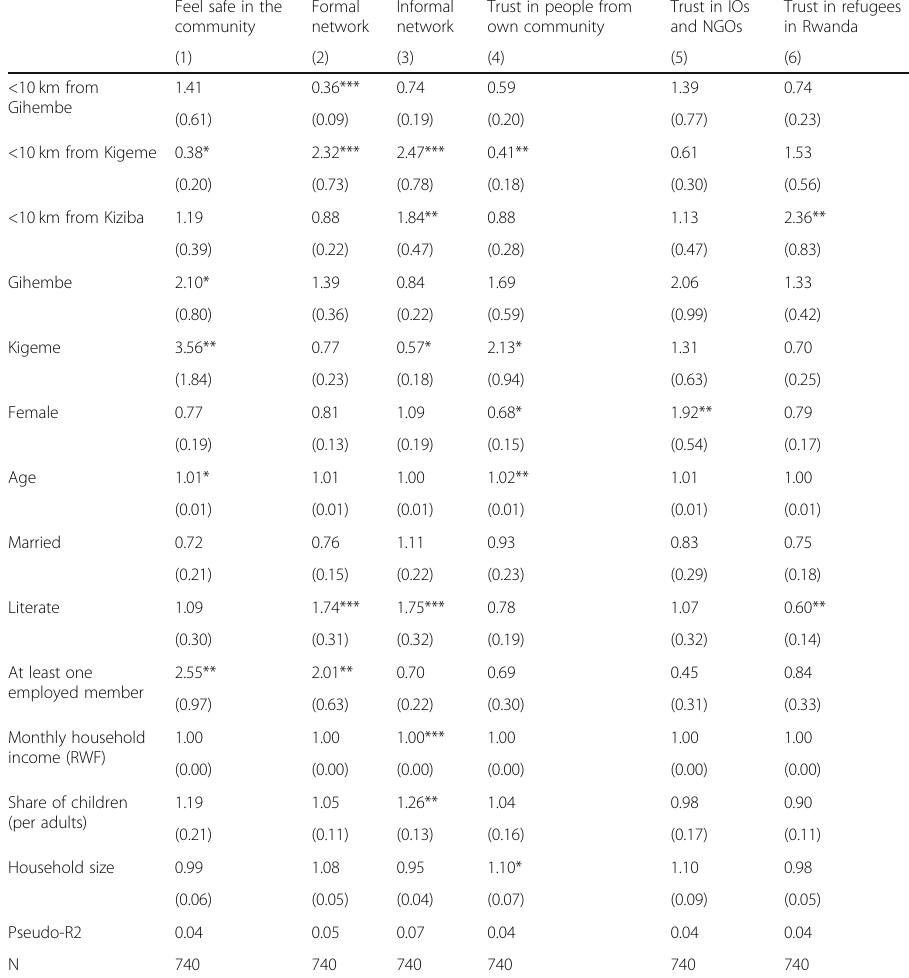
Table 6 Logistic regression analysis, by closest refugee camp (odds ratios) Feel safe in the